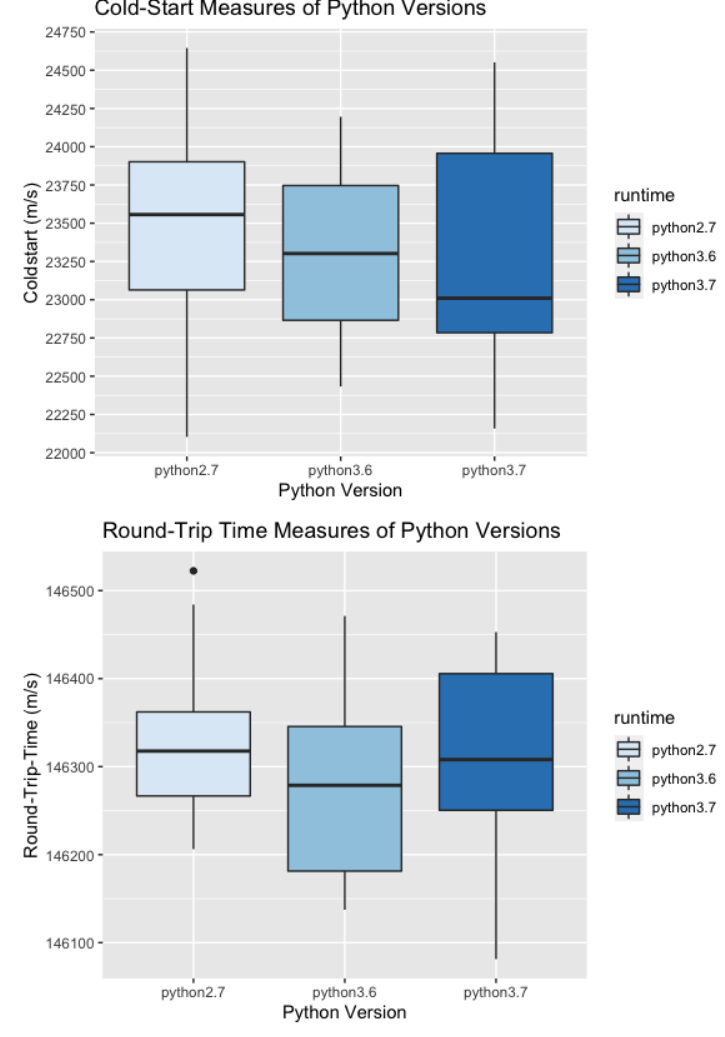
Figure 2. Boxplot of Cold-Start and Round-Trip-Time results for different Python versions. The difference between the Python versions (Tables 3 and 4) means for the Cold-Start vary around 0.1–0.2 s, but for the Round-Trip time no significant change can be detected. However, the